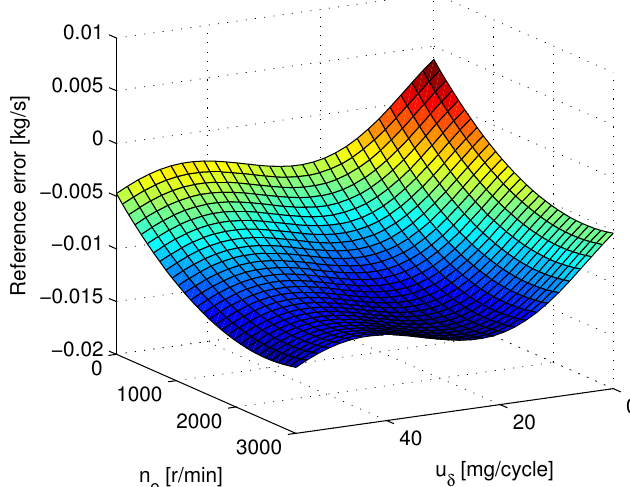
Figure 3. Reference error ∆ W in